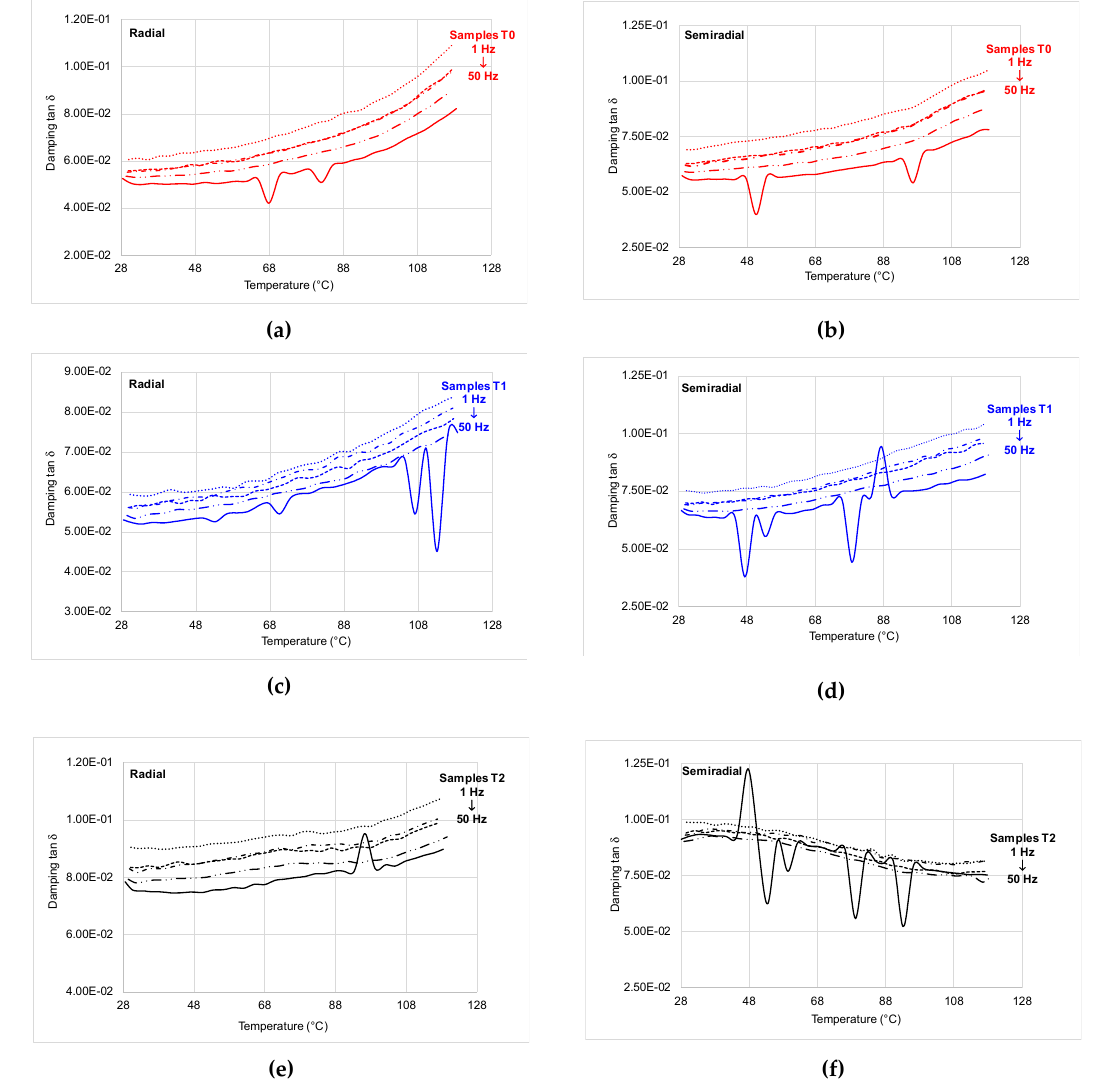
Figure 15. tan δ with temperature: ( a ) control sample – radial cross-section; ( b ) control sample – semi-radial cross-section; ( c ) sample T1 (first treatment) – radial cross-section; ( d ) – sample T1 (first treatment) – semi-radial cross; ( e ) sample T2 (second treatment) – radial cross-section; ( f ) sample T2 (second treatment) – semi-radial cross-section; solid line (50 Hz); long dash dot dot line (10 Hz); dash dot line (5 Hz); square dot line (3.3 Hz); round dot line (1 Hz).